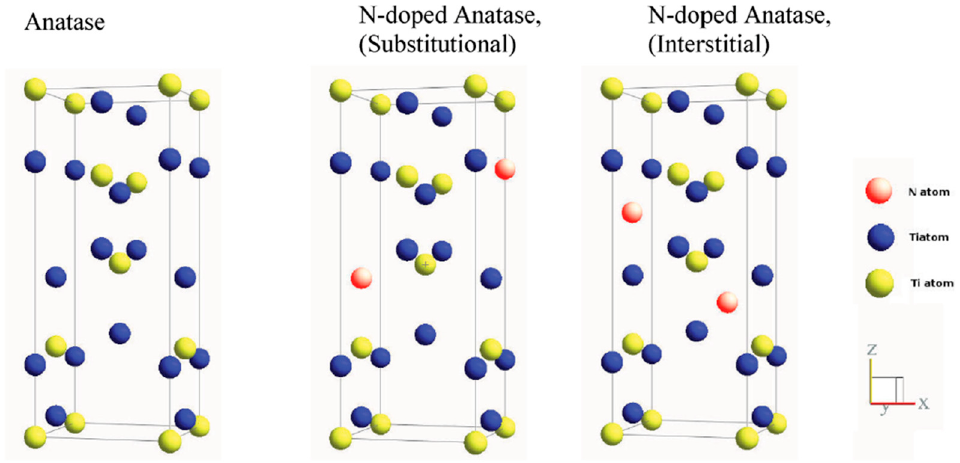
Figure 3. Schematic diagram demonstrating the N doping in the lattice of TiO 2 . Adapted with permission from Reference [41]. Copyright (2011) Royal Society of Chemistry.